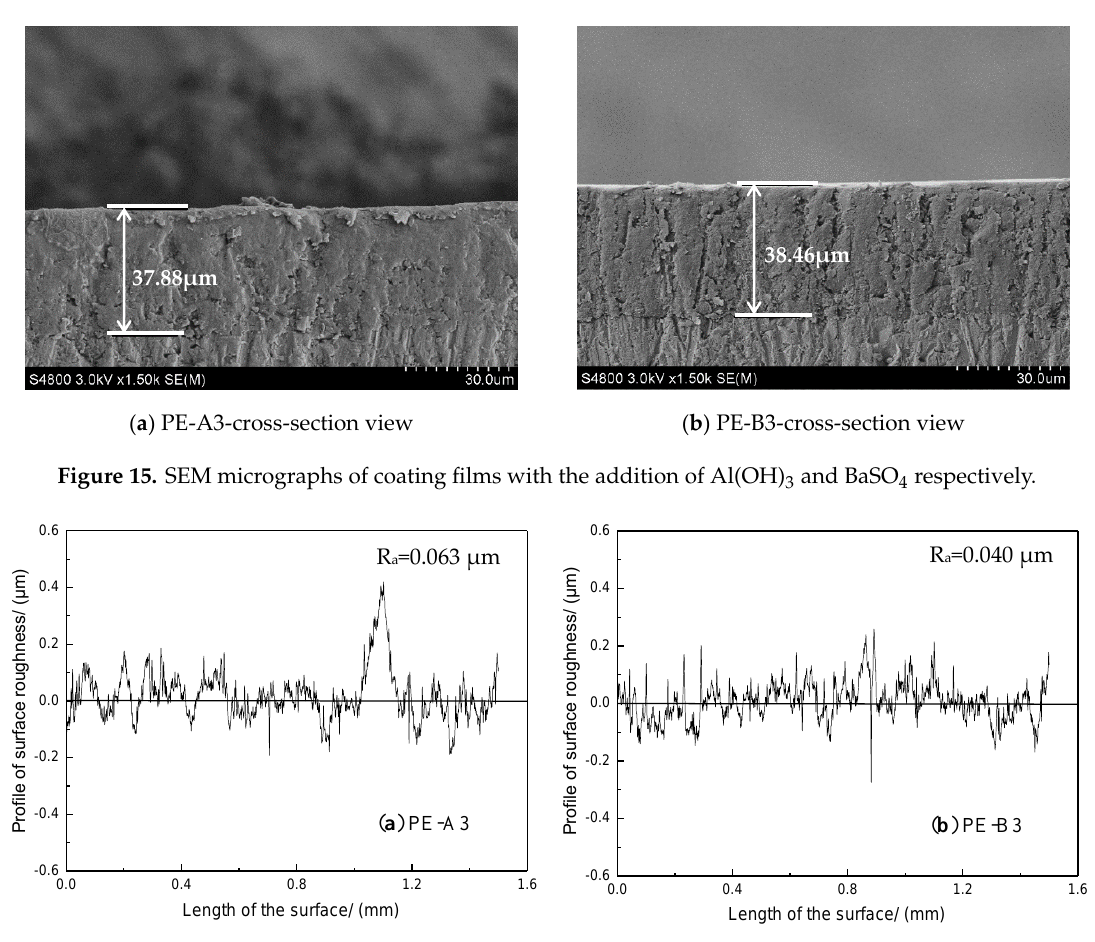
Figure 16. Roughness of the surface of coating films with the addition of Al(OH) 3 and BaSO 4 respectively.